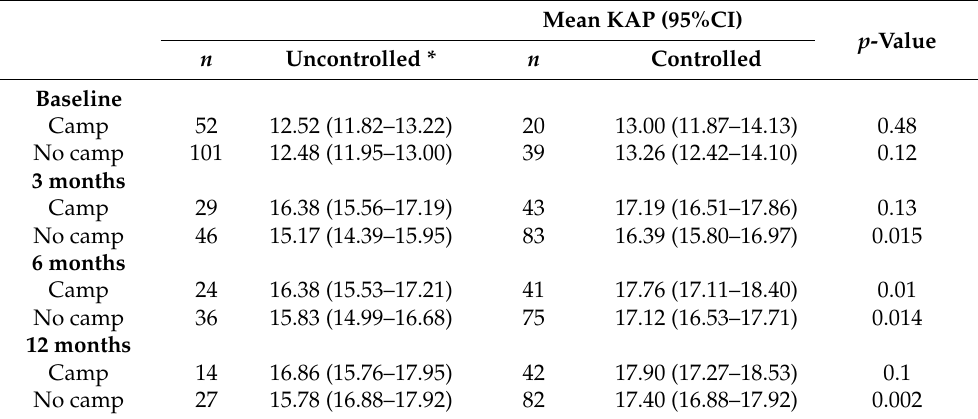
Table 5. Mean KAP scores by level of asthma control and asthma camp attendance at each follow-up